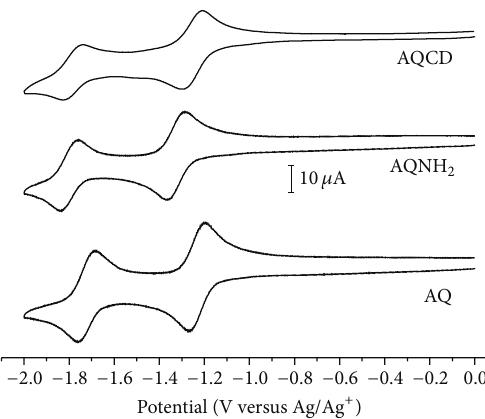
Figure 1: Cyclic voltammograms (CVs) of 0.5mM AQCD, AQNH 2 , and AQ in 0.1M TBAPF 6 /CH 3 CN. Scan rate: 50